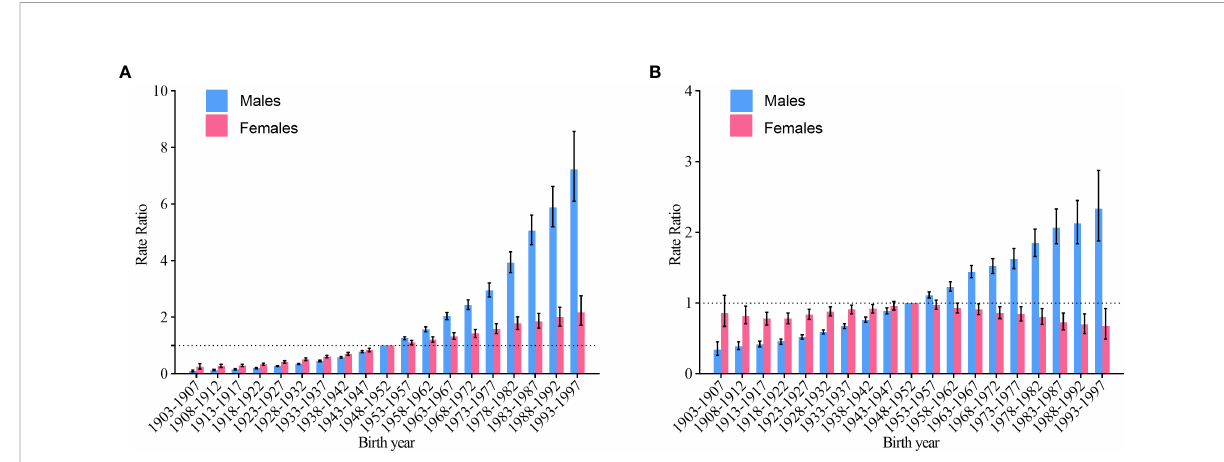
FIGURE 6 Cohort RR of non-Hodgkin lymphoma by gender in China. (A) incidence; (B)